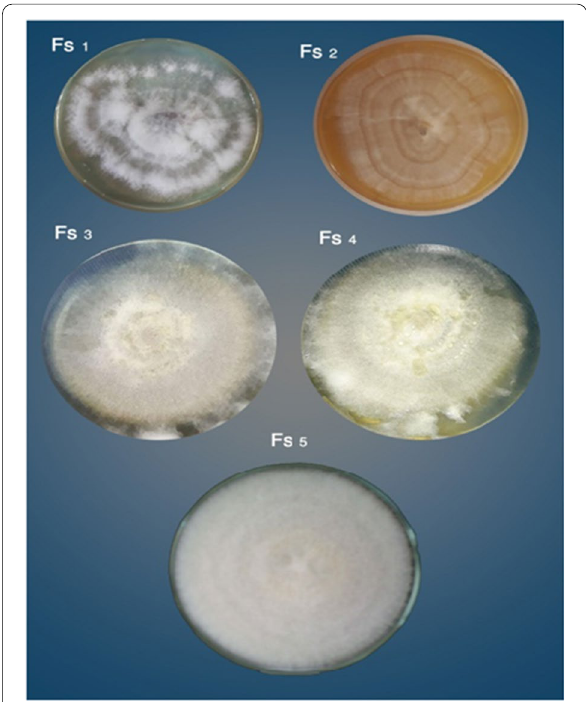
Fig. 4 Different culture of R. solani isolated from infected soil and wheat root samples